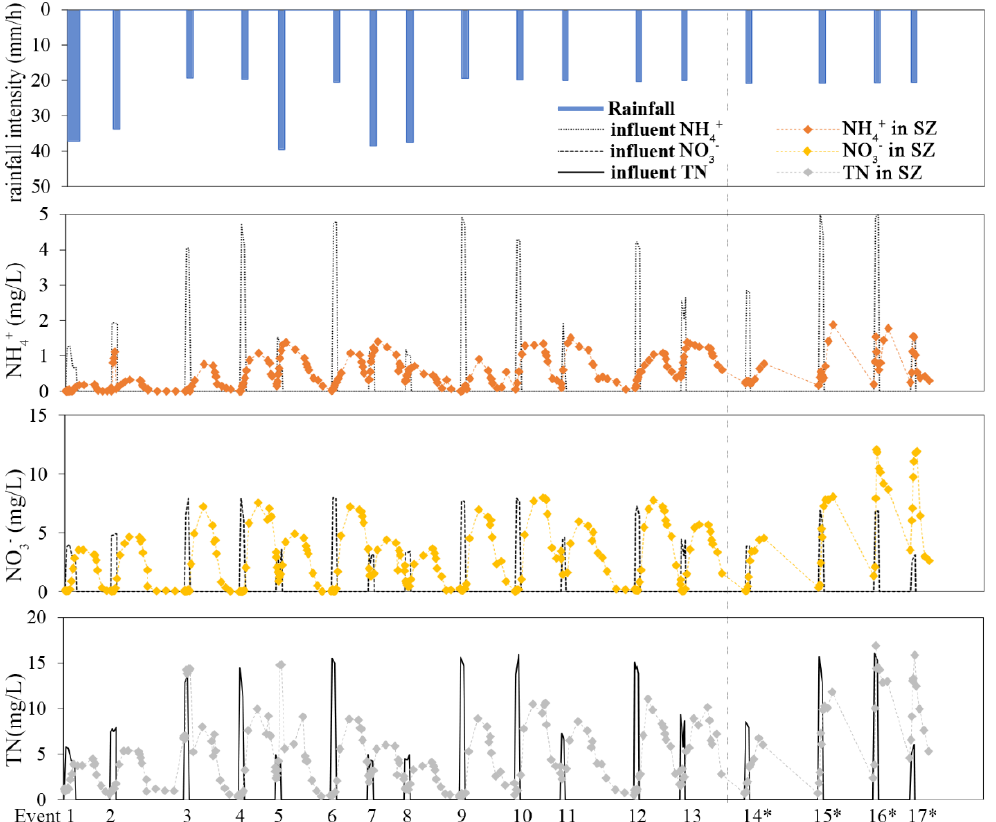
Figure 2. Rainfall intensity and nitrogen concentration change during wet and dry periods. The first 13 events were simulated in a bioretention system with a 300 mm high SZ, and the last four events were simulated in the same system without SZ, which are marked with asterisk.